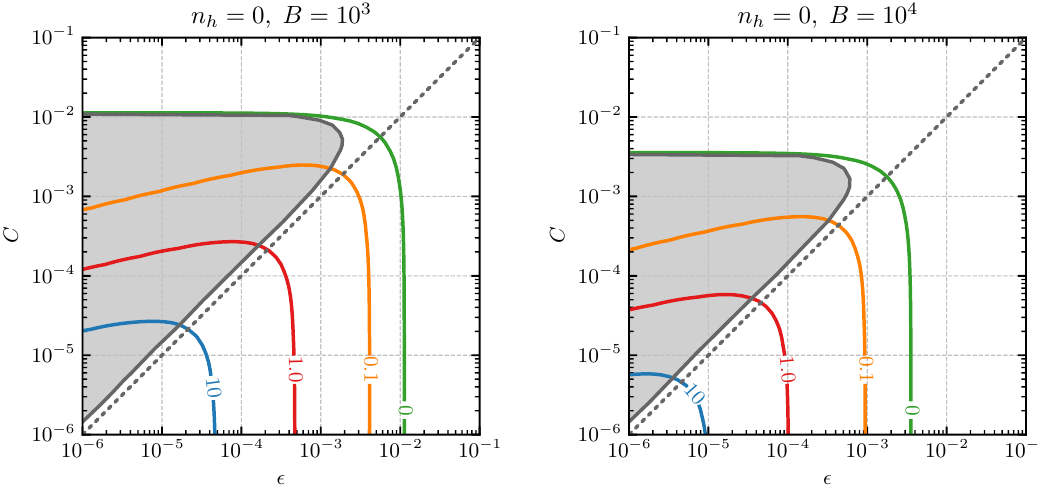
Figure 2 . The C vs. (cid:15) plane. Each line corresponds to a family of Q-ball solutions for different values of the parameter A each given on their respective line. The dotted line denotes C = (cid:15) . The excluded zone is the region where the binding energy goes negative — this corresponds with C (cid:29) (cid:15) , as discussed in the main